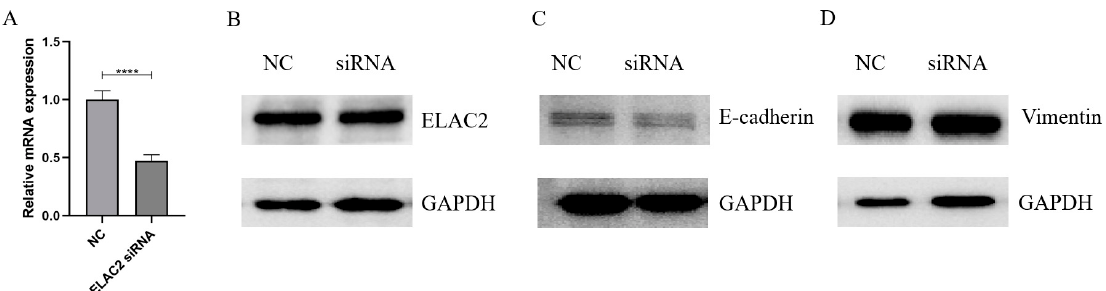
Figure 6. Interference with ELAC2 downregulated EMT-related genes. ( A ) Detection of ELAC2 mRNA expression by qPCR. ( B ) Detection of ELAC2 protein expression by WB. ( C ) Detection of E-cadherin protein expression by WB. ( D ) Detection of vimentin protein expression by WB. **** p < 0. 0001. The bolts presented here were chopped; original blots can be found in Supplementary Figure S1.